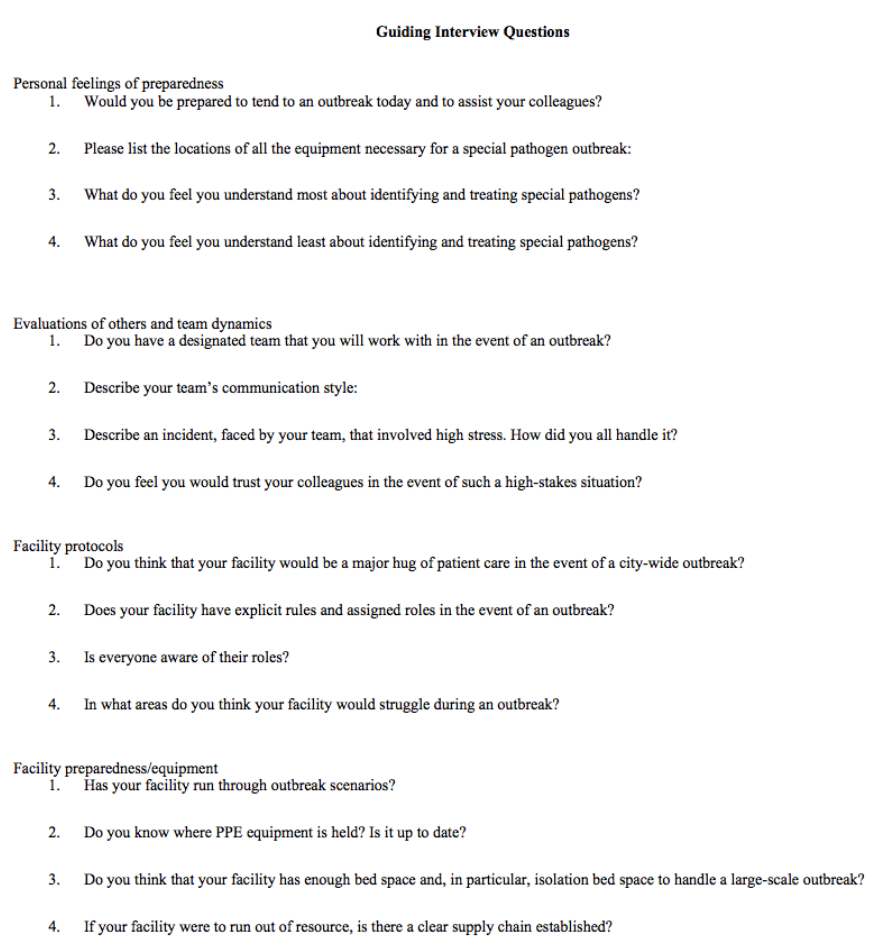
Figure A2. List of questions that served as a guide for how to conduct further interviews with course participants; however, discussions were expected and encouraged to differ, given they covered one of the four main topics: personal feelings of preparedness, evaluations of others and team dynamics, facility protocols, and facility preparedness/equipment. Table A1. Demographic information collected from the survey, indicating that the 44 respondents were primarily hospital workers, with a range of positions including primarily nurses, physicians, and management. There was an equal representation of people who attended training more than 2 months ago and less than 2 months ago.